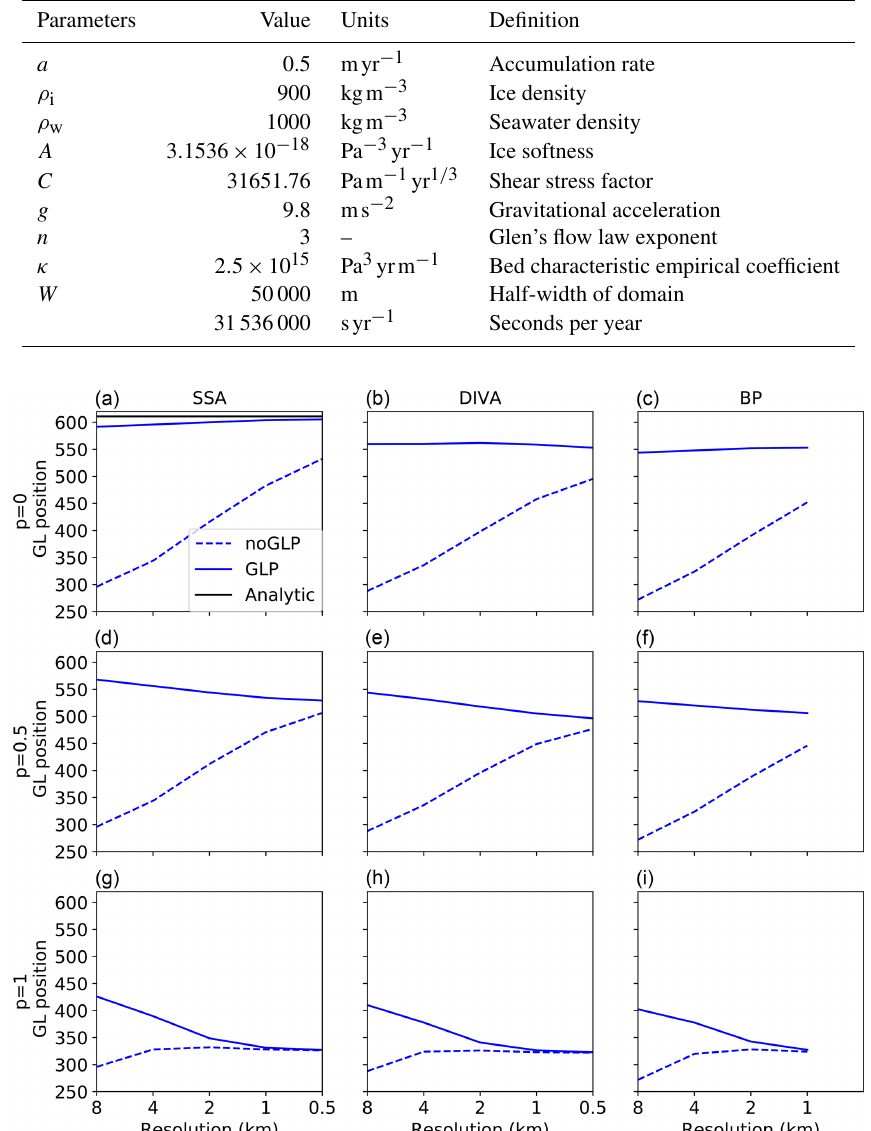
Table 1. Parameter values for the MISMIP3d experiments.